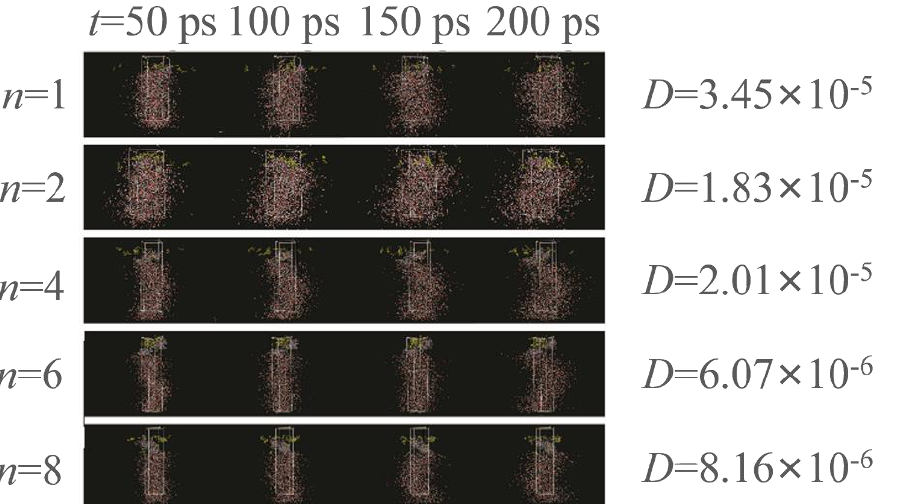
Figure 2. Molecular dynamics (MD) stimulation of the ability of polymers migrating to the water phase.